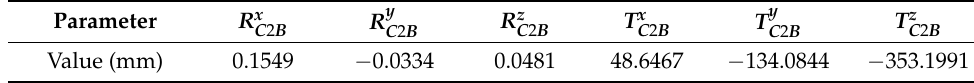
Table 6. Calibrated extrinsic parameters from the CCS to the BCS.